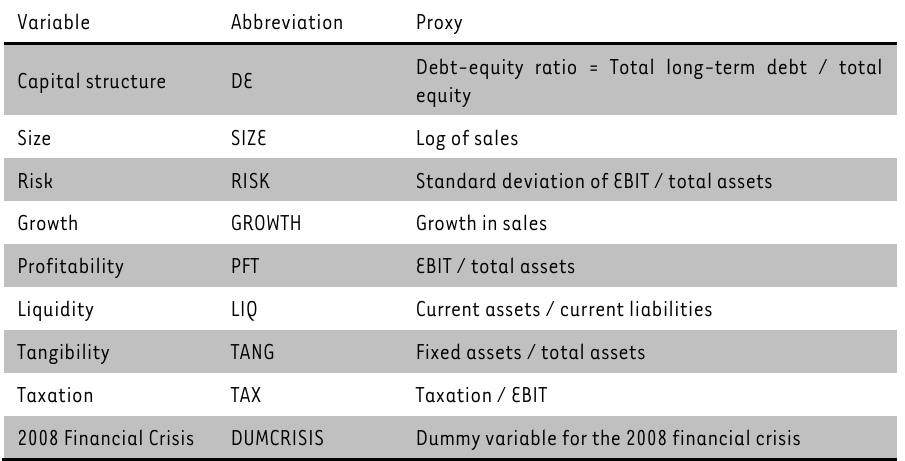
TABLE 2: Summary of proxies for capital